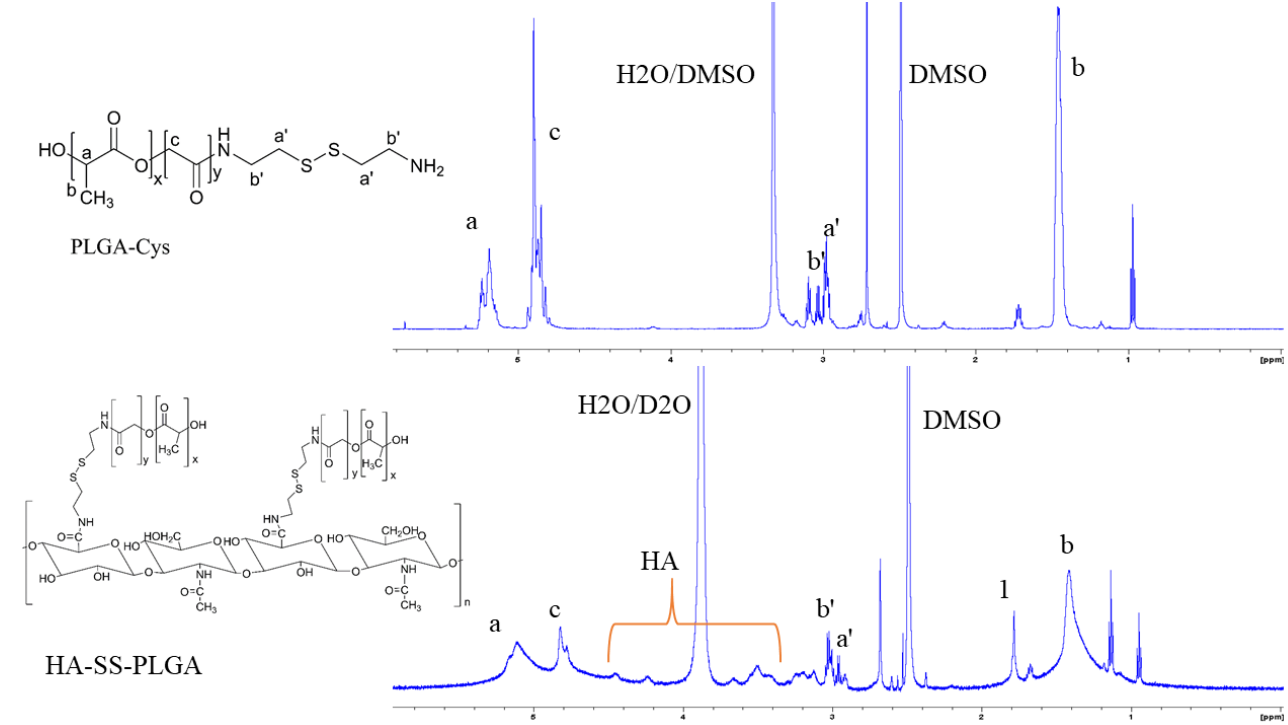
Figure 1. 1 H-NMR of HA-SS-PLGA and PLGA-Cys in DMSO-d6/D2O and DMSO-d6, respectively.